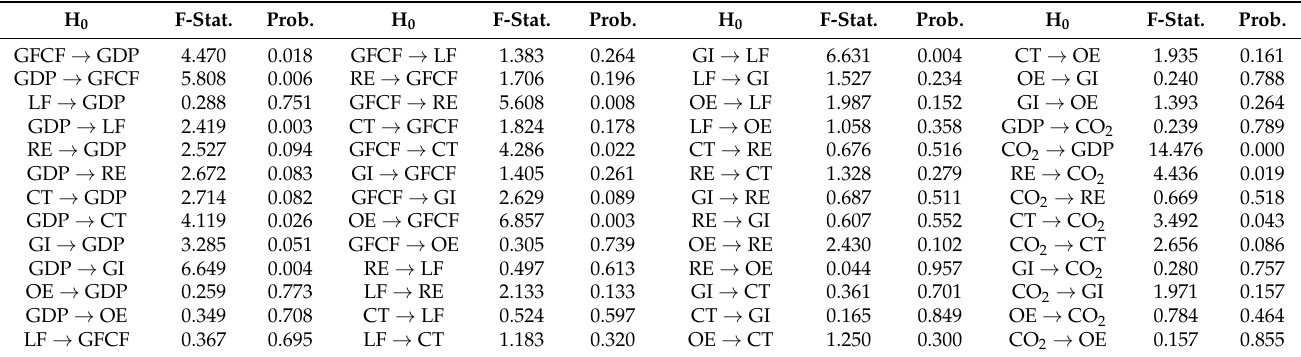
Table 9. The empirical results of Pairwise Granger Causality